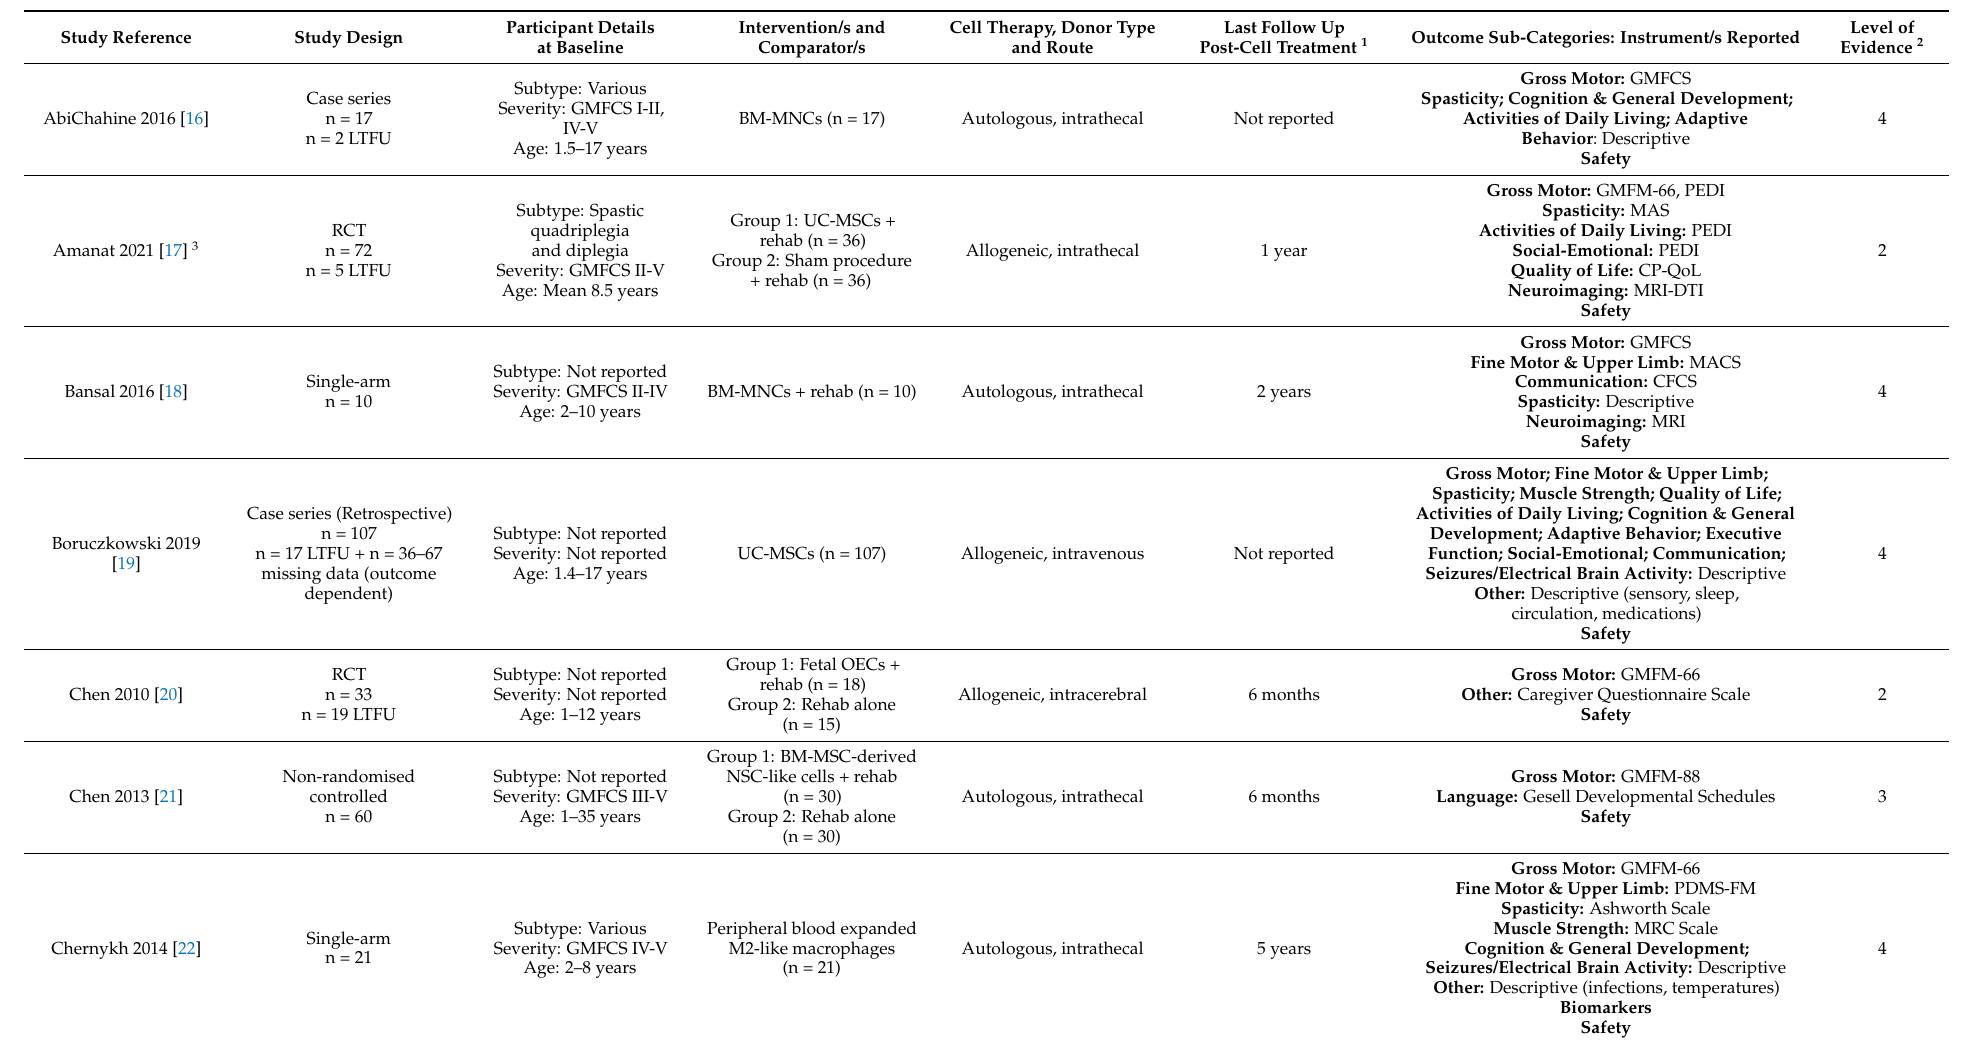
Table 1. Details of included